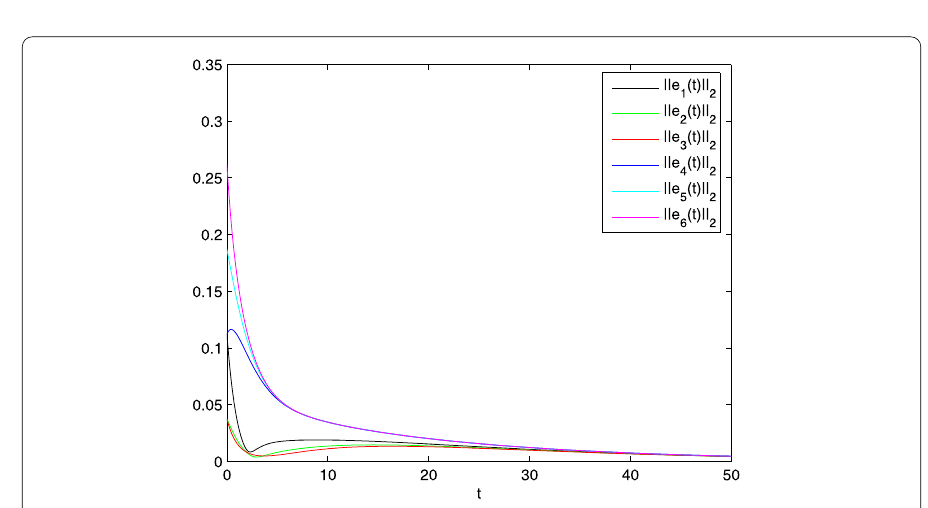
Figure 2 The synchronized error (cid:2) e i ( t ) (cid:2) 2 , i = 1,2,3,4,5,6, of system (32) under pinning control